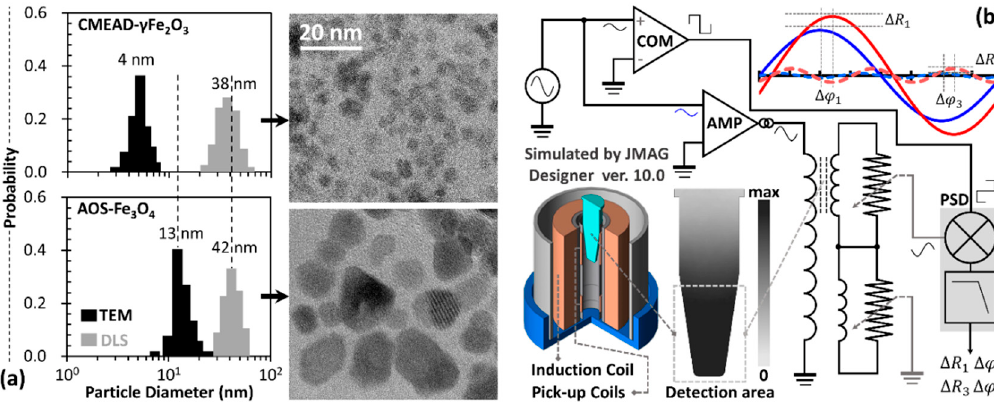
Figure 1. ( a ) Transmission electron microscopy images and dynamic light scattering measurements of the characterized ferrofluid samples; ( b ) Phase-sensitive detection system to measure the complex magnetization harmonics of a 0.1-mL ferrofluid sample placed within an area with a spatially uniform field-distribution. The signal amplitude and phase differences at the fundamental and third-harmonic frequencies ( ∆ R 1 , ∆ ϕ 1 , ∆ R 3 , and ∆ ϕ 3 , respectively) were recorded while varying field strength and frequency of the applied fields.